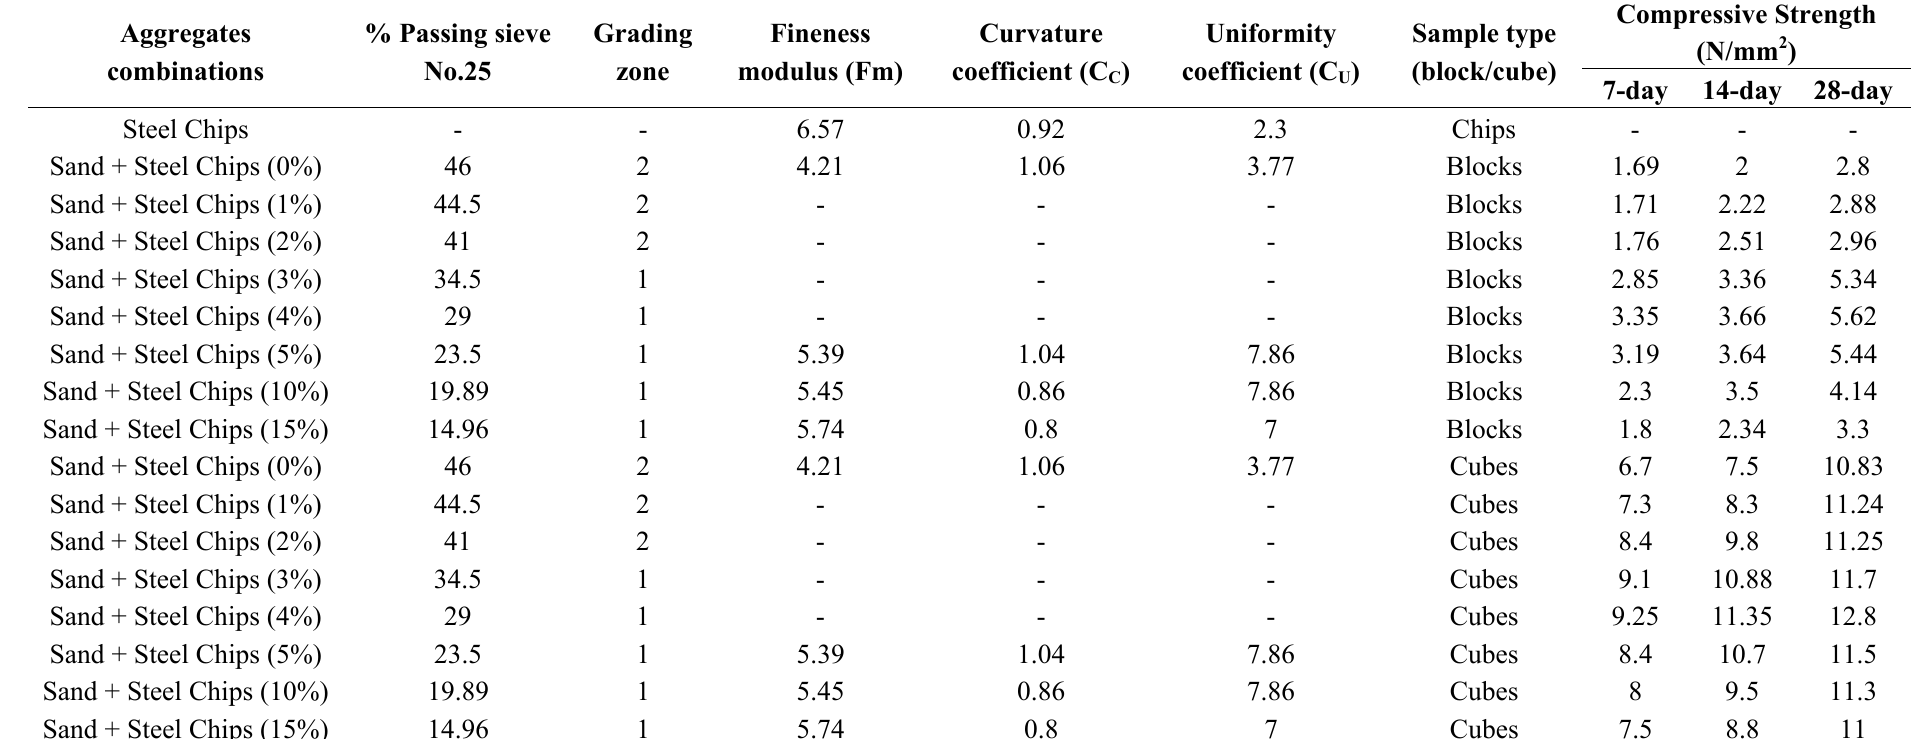
Table 5. Grading parameters and dry compressive strength